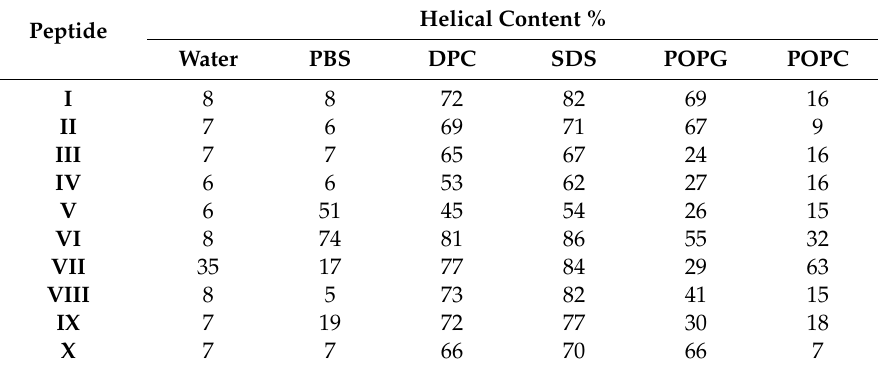
Table 6. Helical content determined based on CD